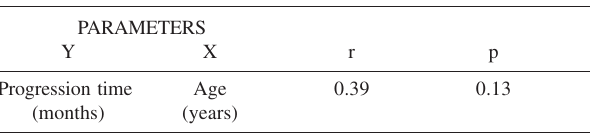
Table 7 - Correlation of progression time (months) and age (years) (Spearman’s correlation test between quantitative ordinal parameters)